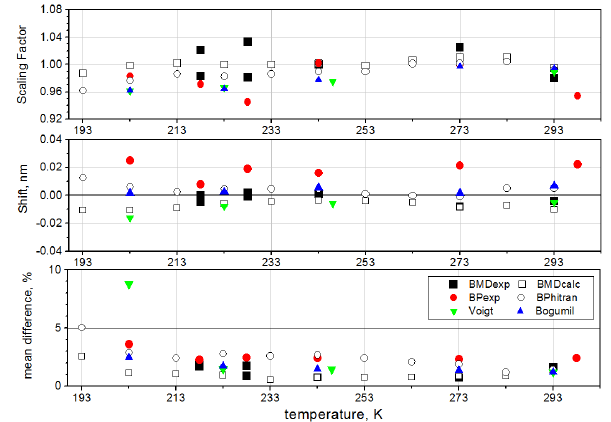
Fig. 6. Comparison of the results from this study with BP, BMD, Voigt et al. (2001) and Bogumil et al. (2003) in the window 325– 340nm (for more details, please read the text): (upper panel) scaling factors (to match other data to new data); (middle panel) wavelength shift (to match other data to new data); (lower panel) relative mean difference (other data after applying corrections for shifts and scal- ing factors minus new data). Filled symbols – experimental data; open symbols – data obtained from the polynomial parameterization (Eq. 1). Squares – BMD, circles – BP, triangles – Voigt et al. (2001) and Bogumil et al. (2003)